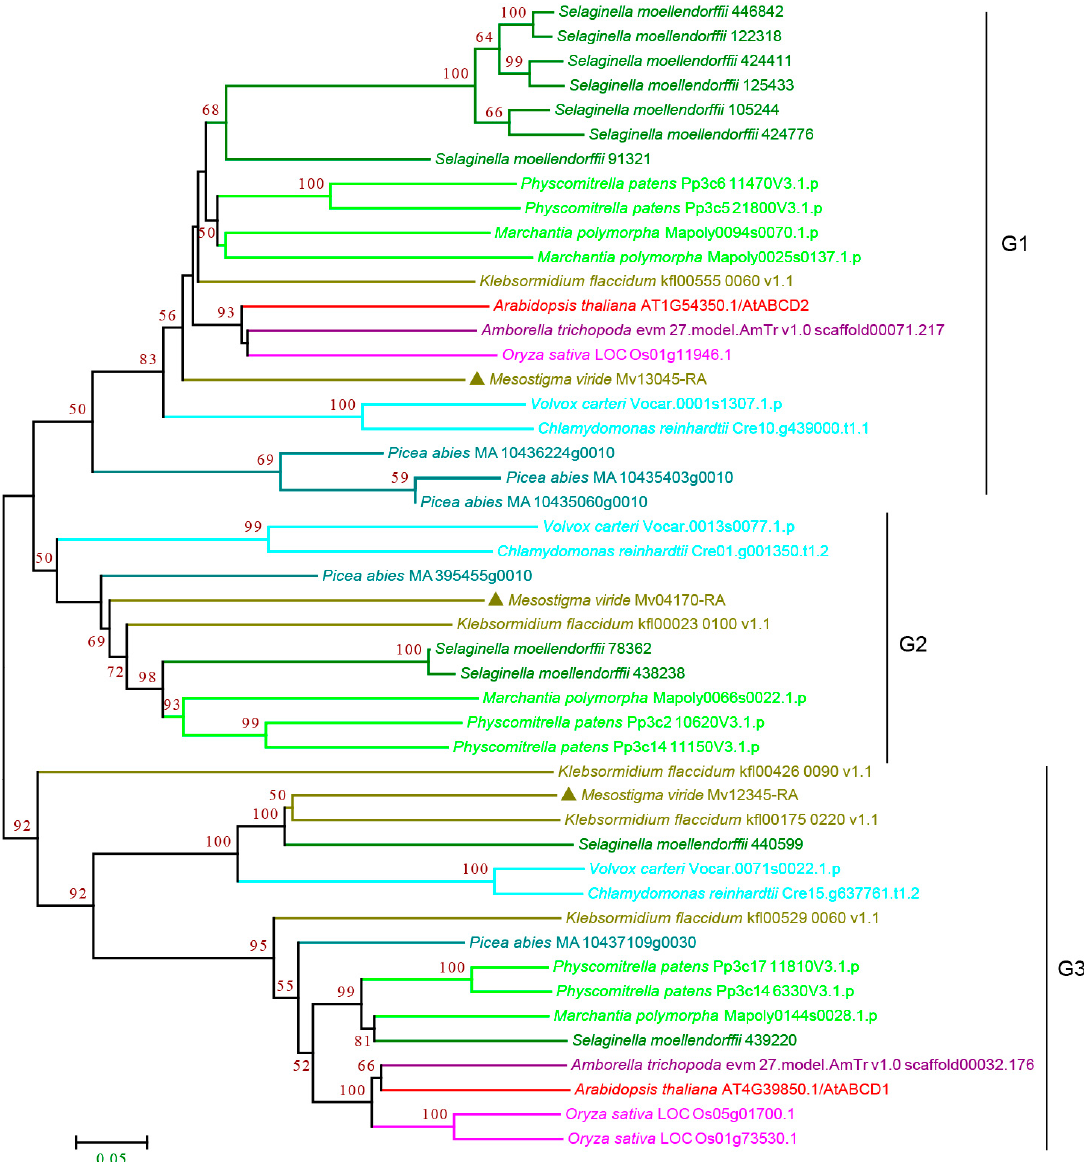
Figure 5. Phylogenetic analysis of ABCD subfamily proteins from 11 evolutionarily representative plant species. A neighbor-joining (NJ) tree was generated using MEGA7 with 1000 bootstrap repli- cates, and bootstrap values >50% are shown on the branches. The M. viride proteins are highlighted by triangles.